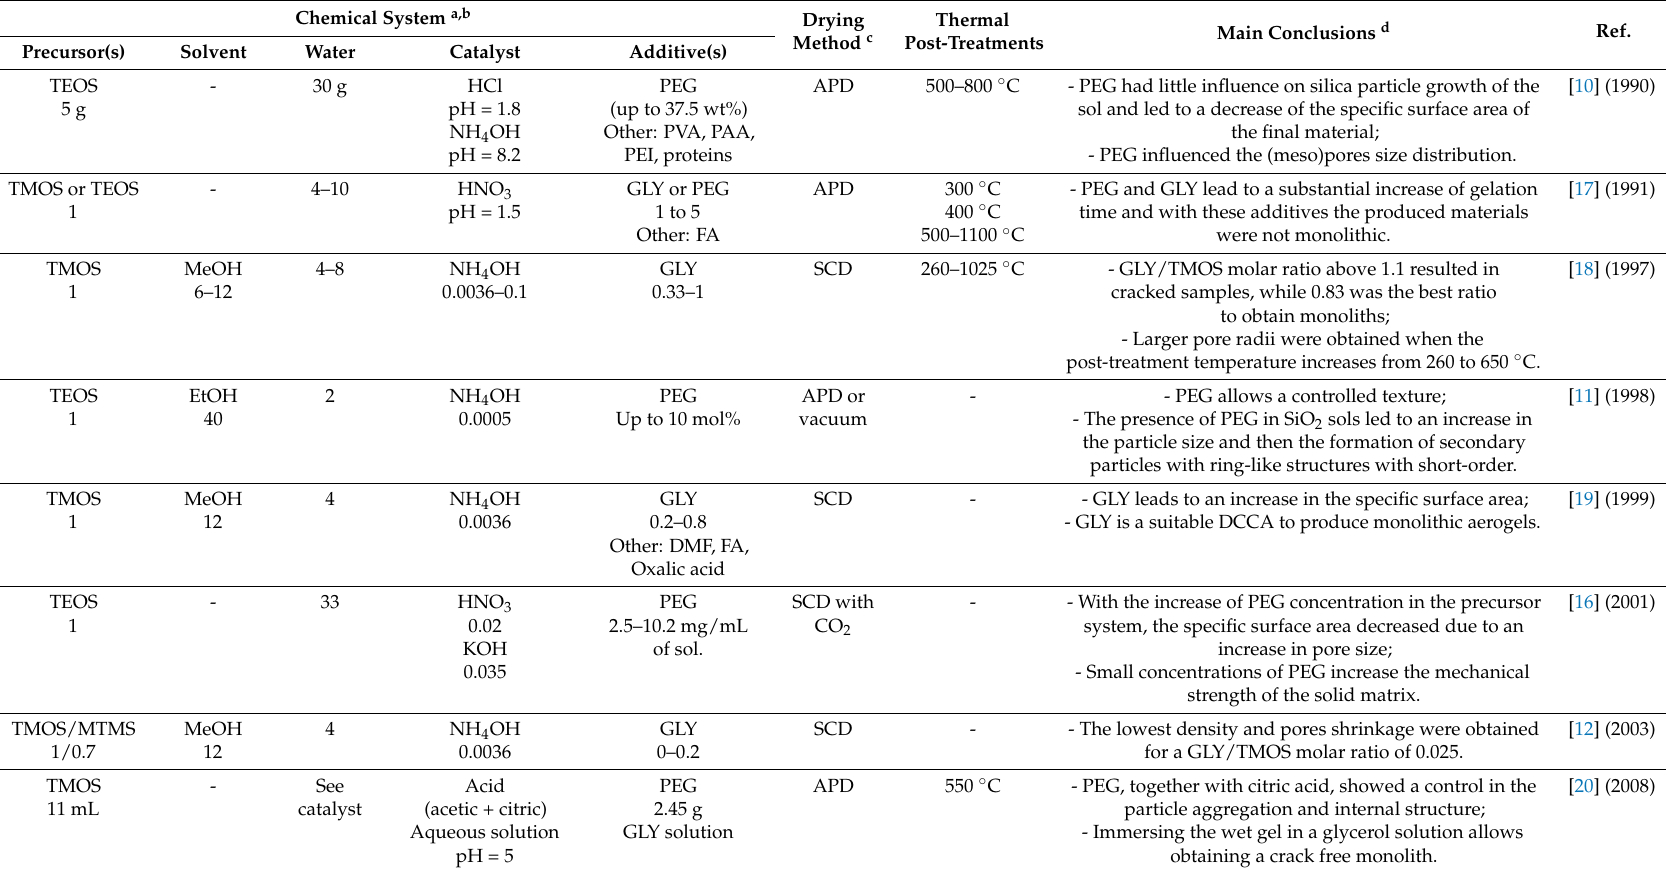
Table 1. Summary of evolution of works related with the study of the effect of GLY and PEG in silica